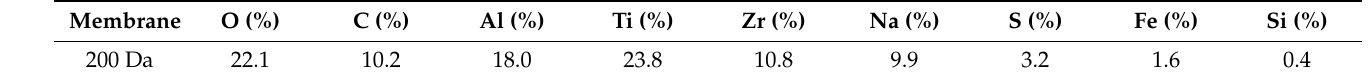
Figure 10. SEM-EDS analysis of the 200 Da ceramic membrane after the NF test as well as the mapping of the most significant elements on the active layer and support layer after NF test. ( A ) Support layer; ( B ) cross-section; ( C ) active layer; ( D ) sulfur element on the active layer; ( E ) sodium element on the active layer; ( F ) aluminum element on the active layer; ( G ) titanium element on the active layer; ( H ) sulfur element on the support layer; ( I ) sodium element on the support layer; ( J ) aluminum element on the support layer; ( K ) titanium element on the support layer. Layer magnifications are × 1000 and cross-section magnification is × 100. Table 5. EDS analysis of active layer of the ceramic membrane after the NF test (200